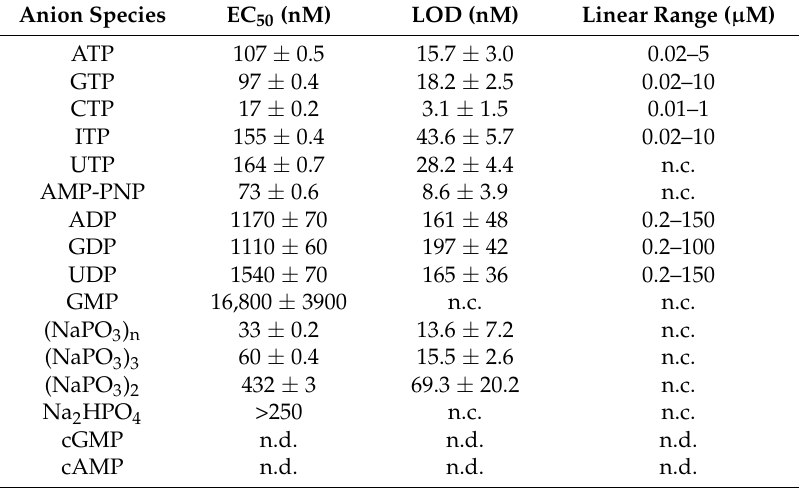
Table 2. Summary of the binding properties of the Probe 1 to different phosphate-containing anions a .